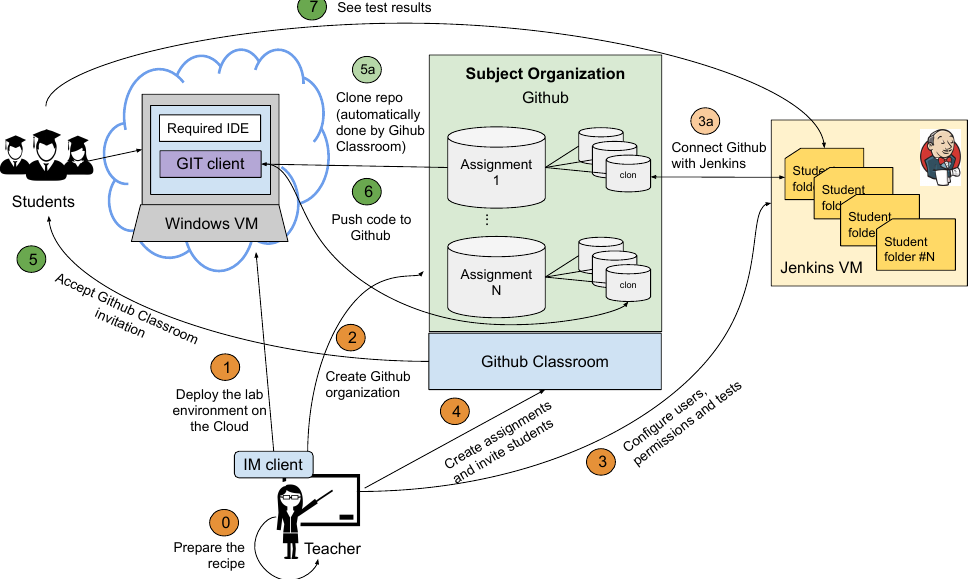
Figure 1. Architecture of the proposed solution. In orange we represent the actions to be done by the teacher and, in green, the actions to be done by the